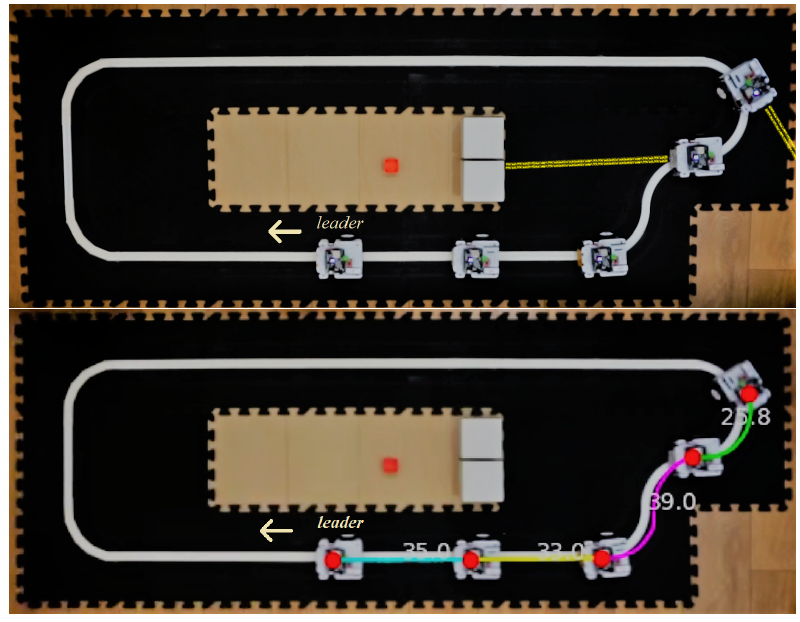
Figure 5. Top: Unreliable measurement of the distance sensor, d m ( t ) . Bottom: offline estimation of the true distance d ( t ) along the